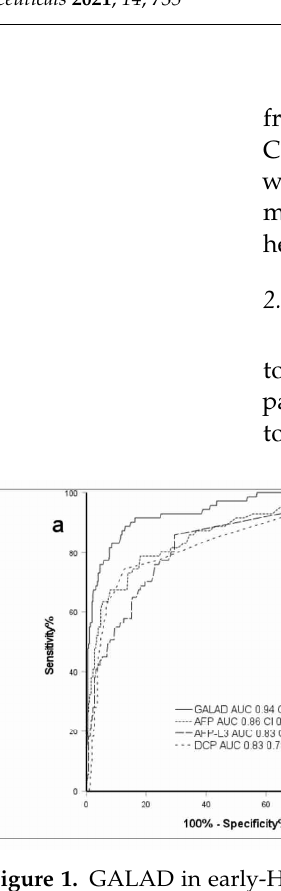
Figure 1. GALAD in early-HCC and intermediate to advanced HCC. ( a ) ROC-Curve for GALAD, AFP, AFP-L3, DCP, GALAD in early HCC (BCLC 0/A); ( b ) ROC-Curve for GALAD, AFP, AFP-L3, DCP in intermediate to advanced stage HCC (BCLC B/C/D); DeLong test p ≤ 0.001. GALAD: gender, age, AFP-L3, AFP, DCP score, HCC: hepatocellular carcinoma, HBV: chronic hepatitis B infection, HCV: chronic hepatitis C infection, AFP: alpha-fetoprotein, AFP-L3: ratio of LCA-reactive AFP to total AFP, DCP: des-gamma-carboxyprothrombin, AUC: area under the curve, CI: confidence inter- val.